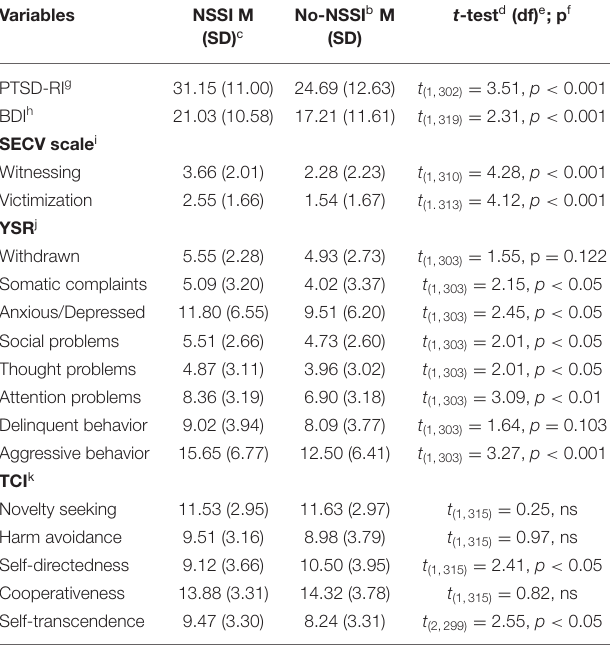
TABLE 2 | Results of t -tests comparing problem scores and personality characteristics in delinquents with and without NSSI a .